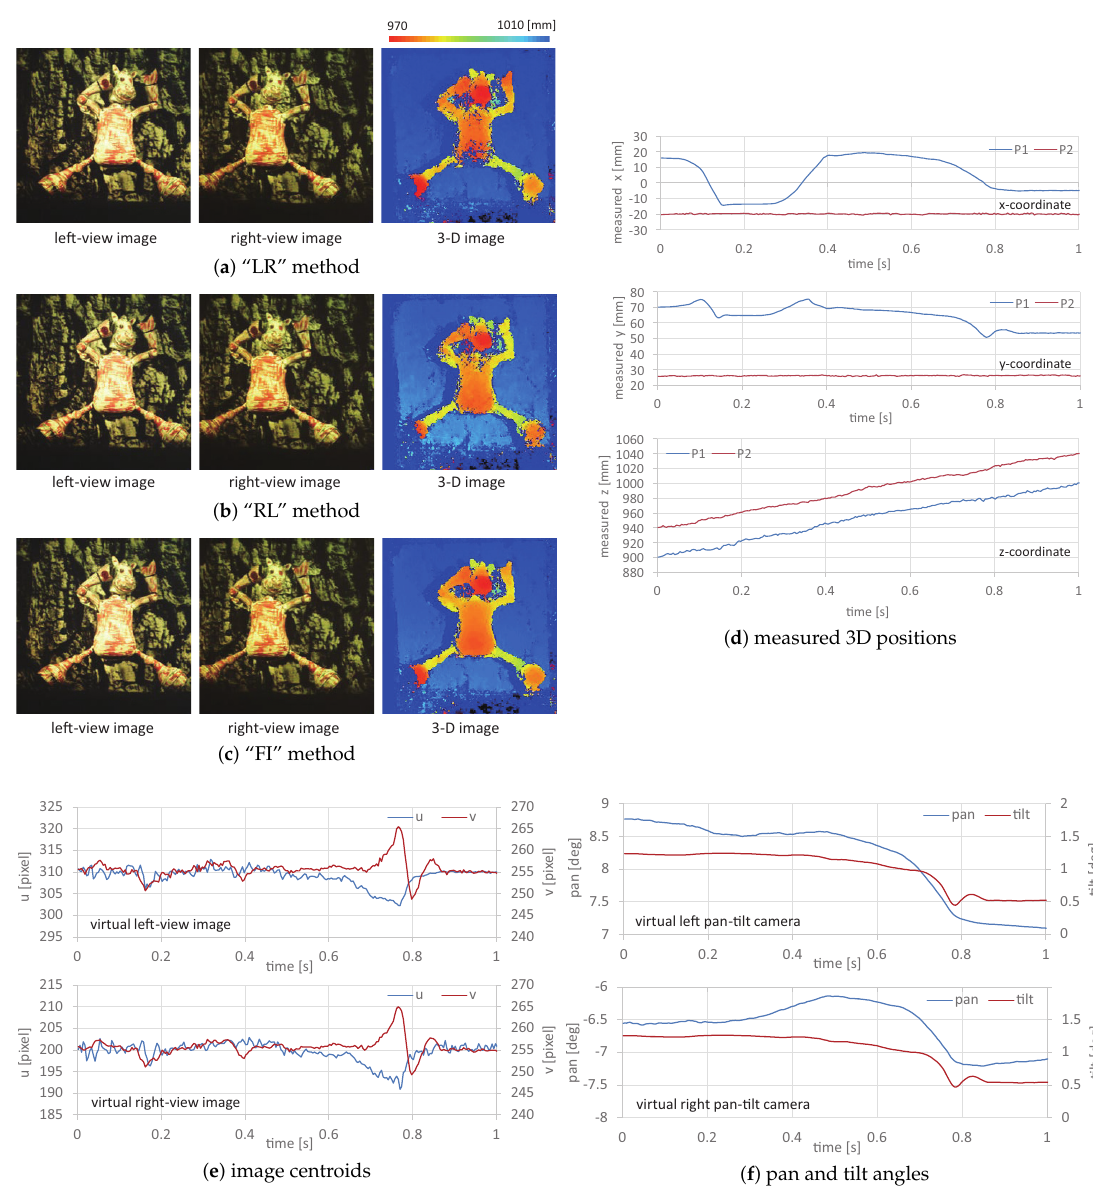
Figure 18. Measured 3D images and positions, image centroids, and pan and tilt angles of virtual left and right pan-tilt cameras when observing a dancing doll: ( a ) “LR” method; ( b ) “RL” method; ( c ) “FI” method; ( d ) measured 3D positions; ( e ) image centroids; ( f ) pan and tilt